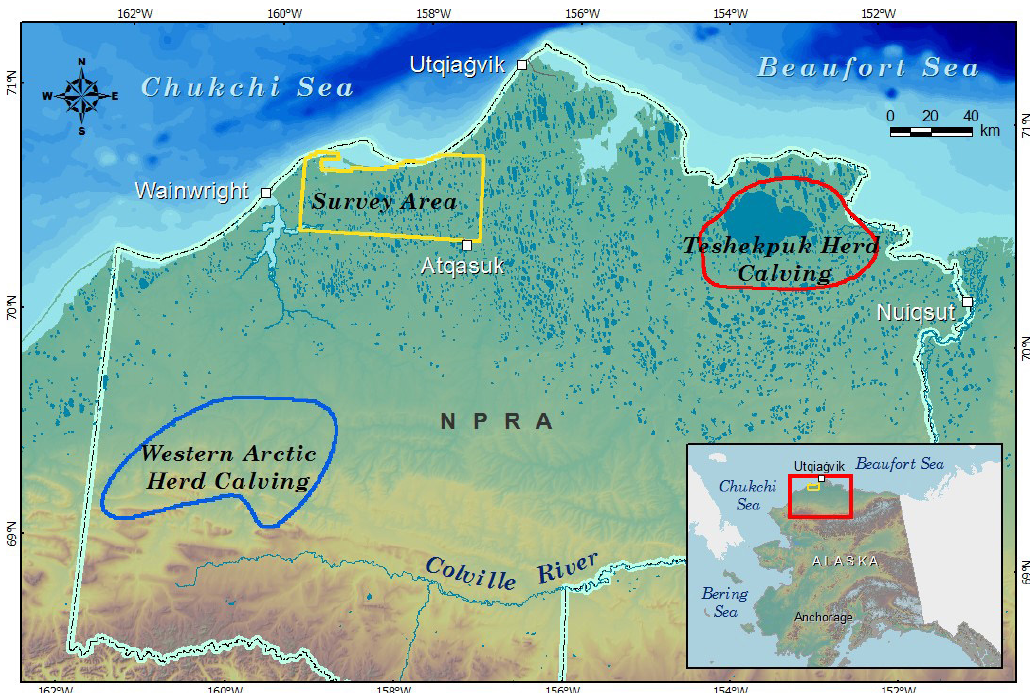
Figure 1. The caribou study area for surveys conducted during mid-June 2013–2015 in relation to high density (50% isopleth of all collared females) calving areas for the two adjacent